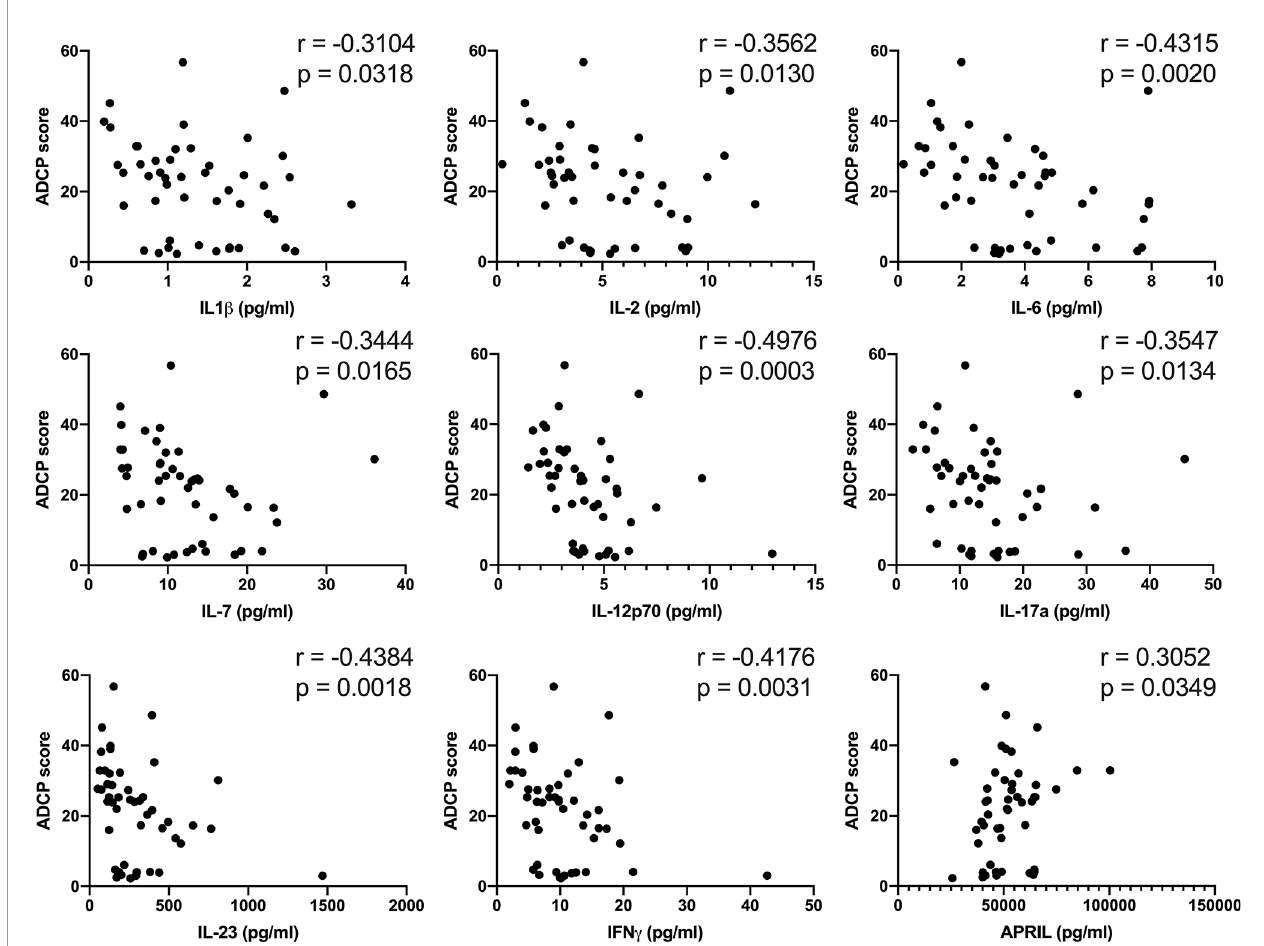
FIGURE 4 | Plasma levels of pro-in fl ammatory soluble factors in BDBV survivors are inversely associated with ADCP. Associations between the plasma levels of IL-1 b , IL-2, IL-6, IL-7, IL-12p70, IL-17a, IL-23, IFN g , as well as APRIL and ADCP in BDBV